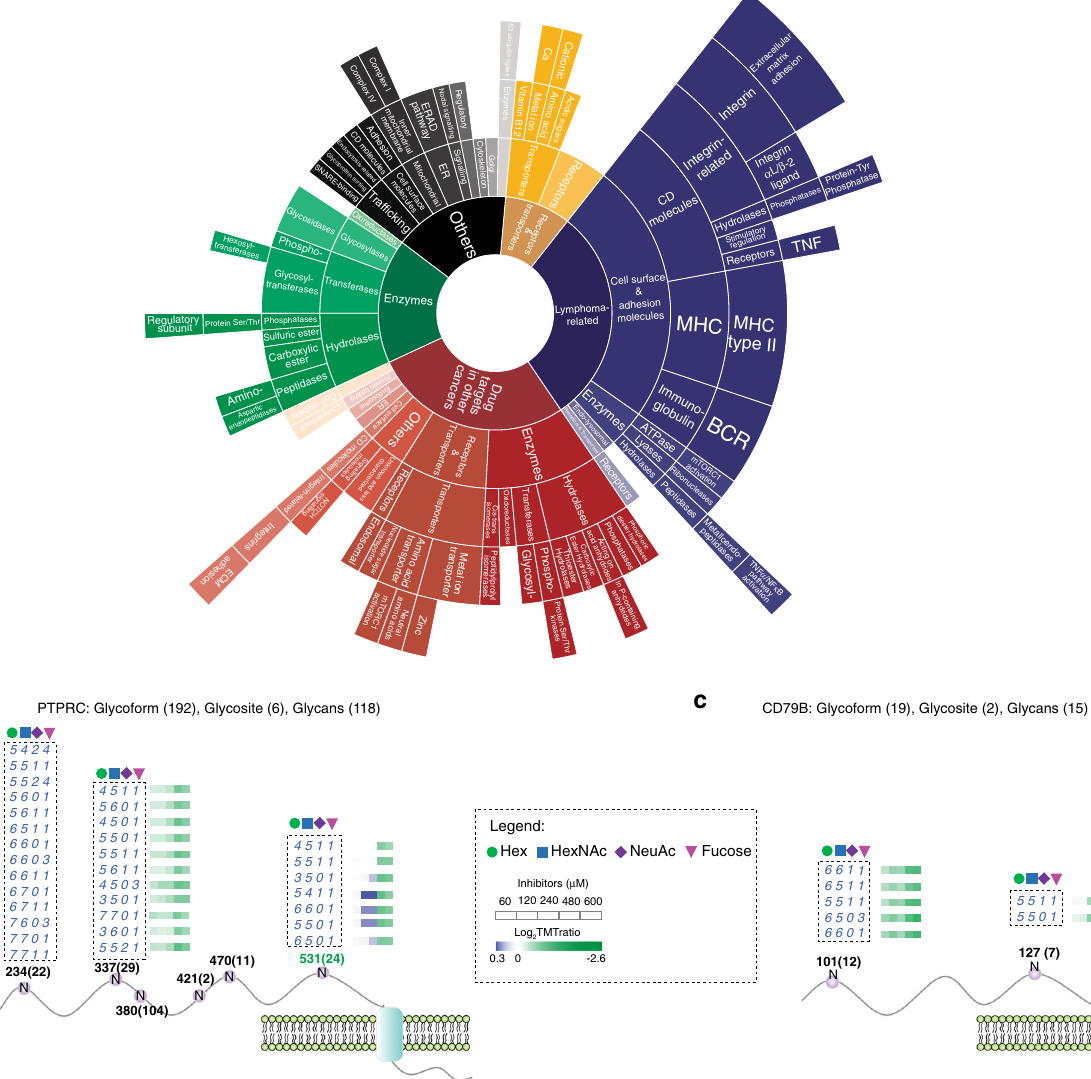
Fig. 5 Functional annotation of 2FF-affected glycoproteins. a A sunburst plot visualizing the functional classi fi cation of the glycoproteins that bear signi fi cantly changed glycoforms upon 2FF treatment. Signi fi cant regulation is de fi ned using Z score >2 or < − 2. b , c Visualization of all quanti fi ed glycosylation sites (N) on PTPRC ( b ) and CD79b ( c ) under 2FF treatment with speci fi ed residue number and number of quanti fi ed glycoforms in bracket. A glycosite that showed a signi fi cantly changed glycosylation level is marked in green. Regulated glycoforms are shown with their glycan compositions presented as the numbers of Hex, HexNAc, NeuAc, and Fucose (dashed box). Determined fold changes of glycoforms upon 2FF treatment with various concentrations are shown by color-coded rectangles. Source data are provided in supplementary data 5 and Source Data fi